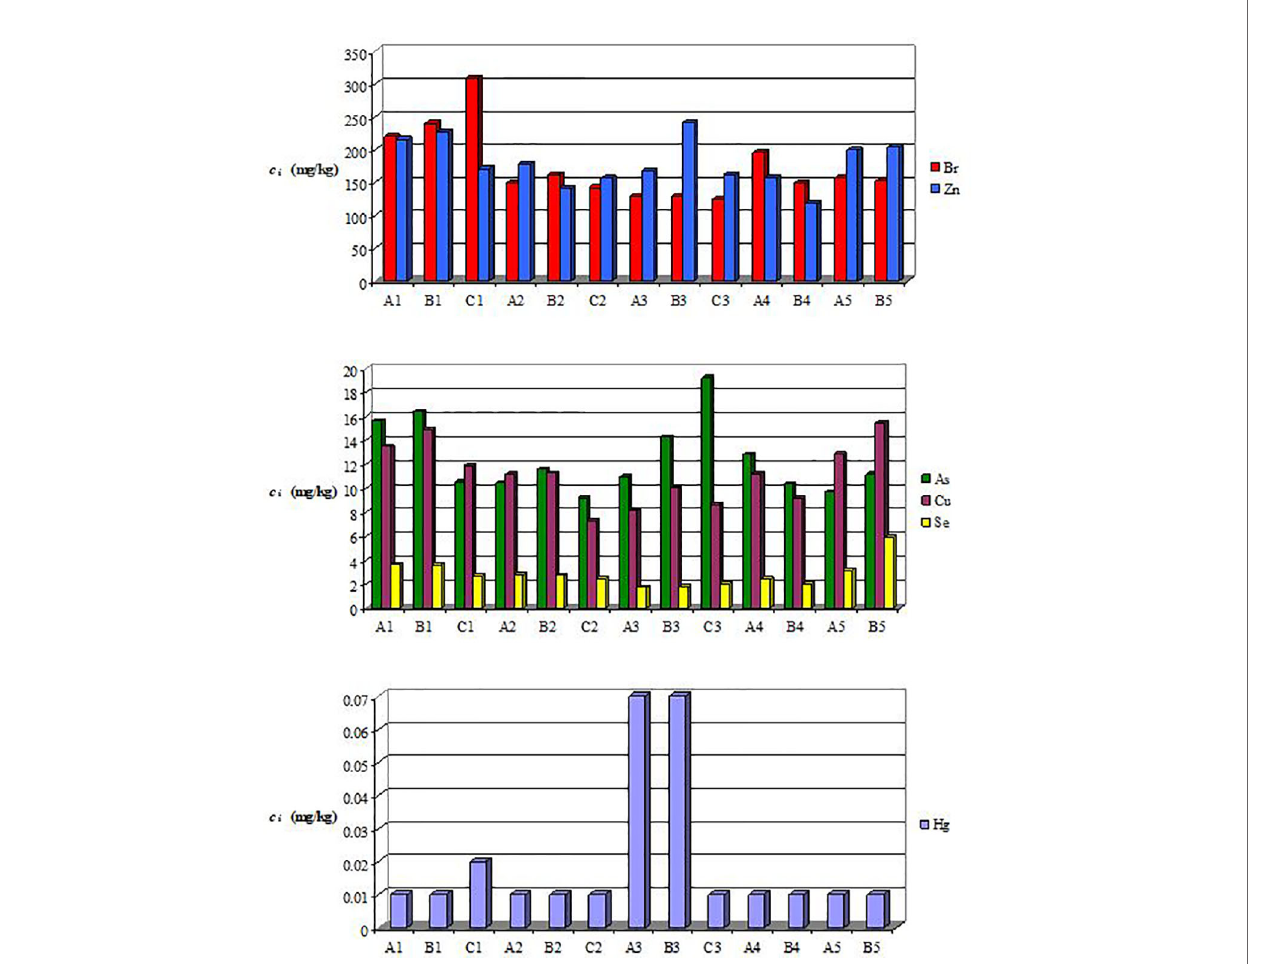
FIGURE 4 | Levels of monthly concentration of trace elements in the soft tissue of mussel classes A, B, and C: 1 − February, 2 − March, 3 − April, 4 − May, 5 − June.